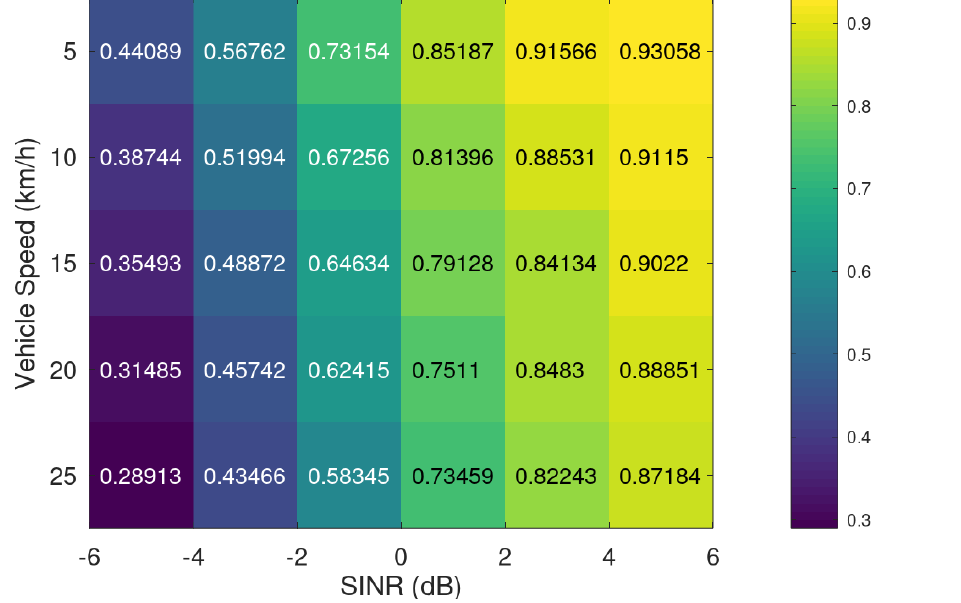
Figure 11. Performance colormap over vehicle speed and SINR in an equal-gain two-paths Rayleigh fading channel with delay 5